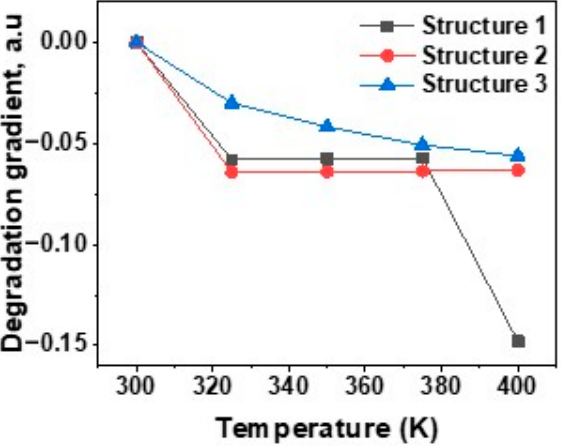
Figure 10. Degradation gradient of PSC for different electron transport layers.